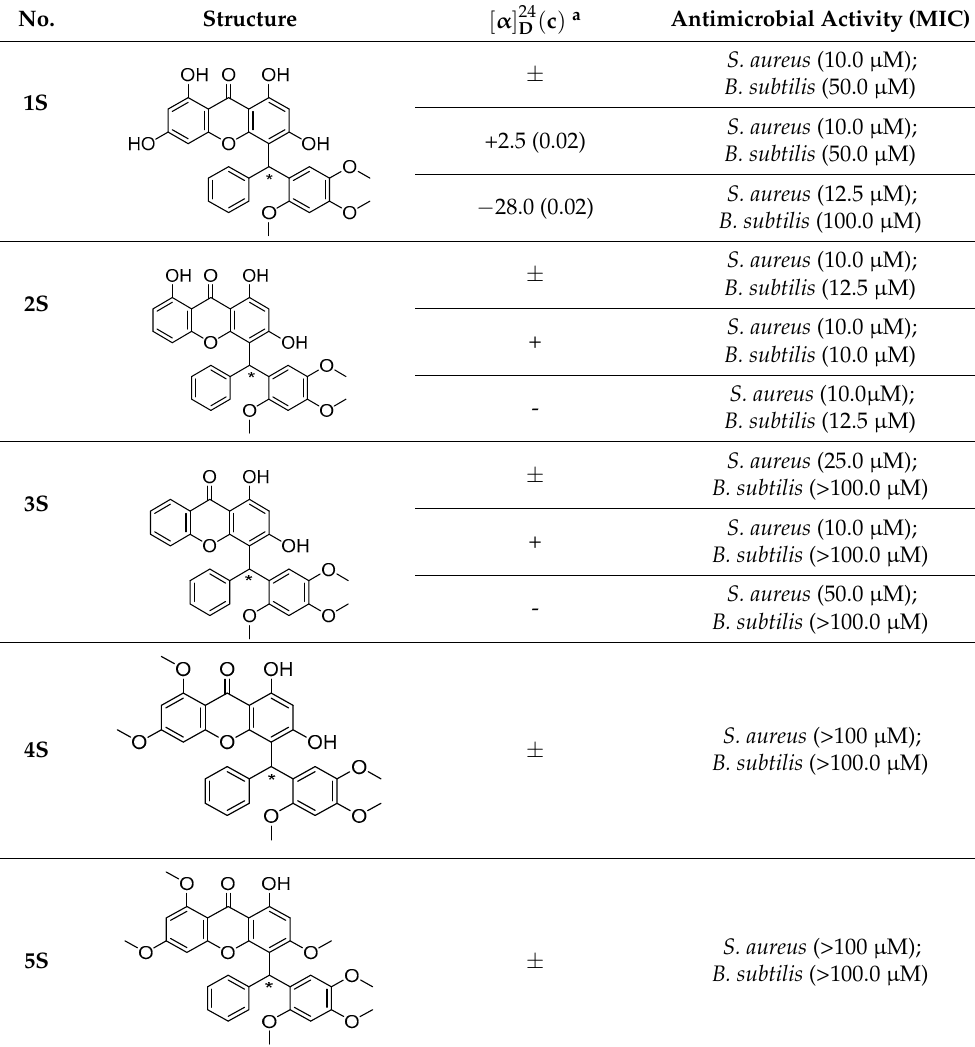
Table 7. Antimicrobial activity of muchimangins analogues.